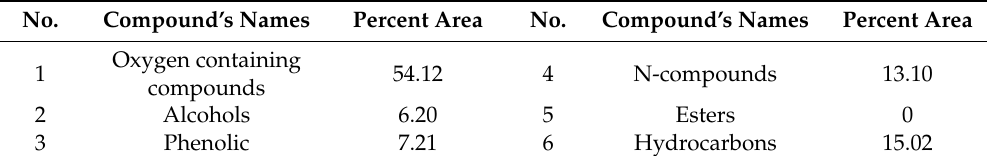
Table 3. Di ff erent groups of compounds identified in SSP.